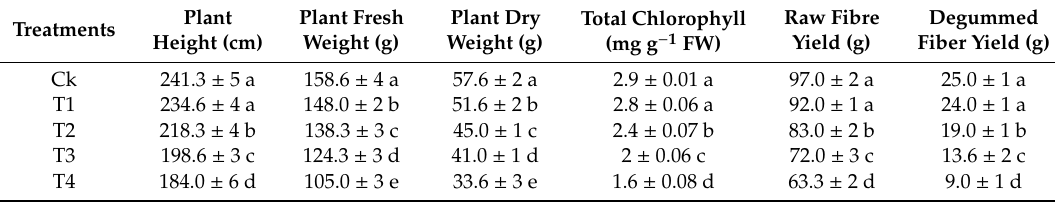
Table 1. E ff ect of mixing of two di ff erent soils on plant height, plant fresh weight, plant dry weight,